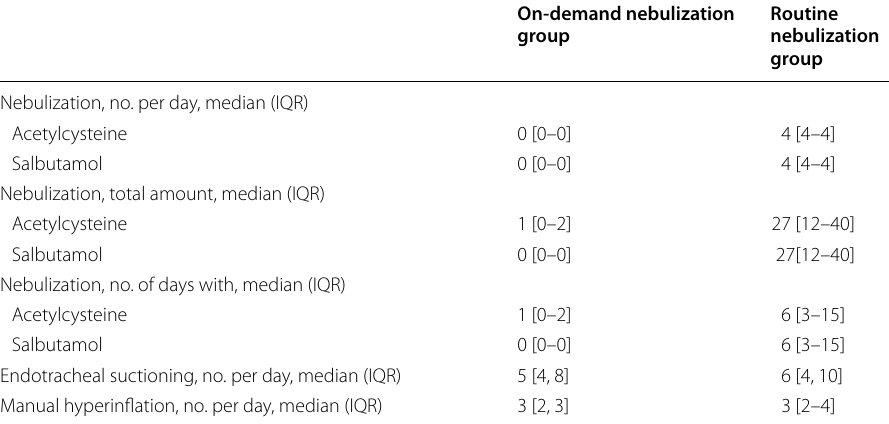
Table 2 Respiratory management of patients receiving demand nebulizations vs. routine